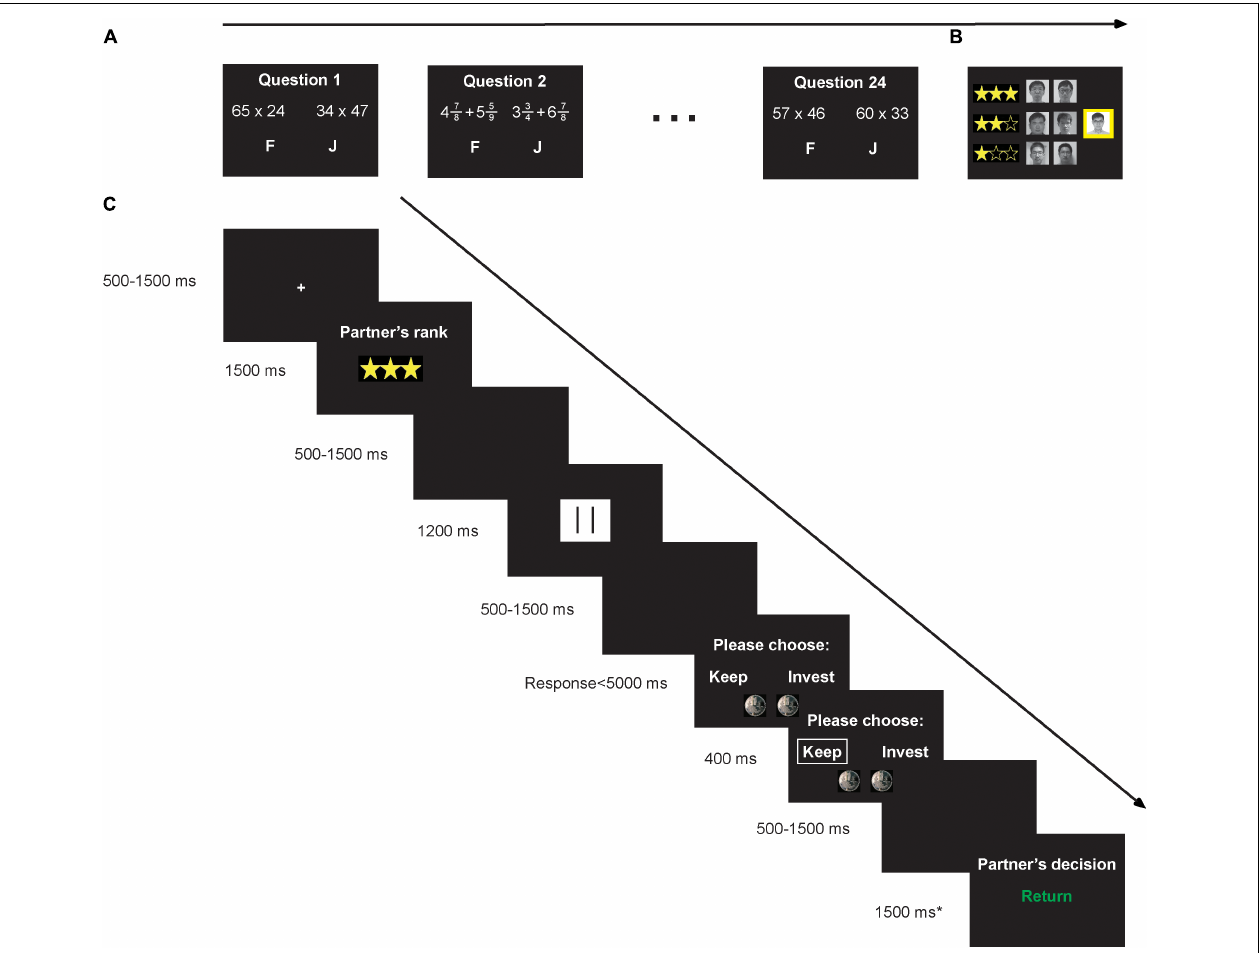
FIGURE 1 | Schematic diagram of the experiment. (A) In the rank-inducing task (i.e., math quiz), participants were given 10 s to select which of two arithmetic expressions had a greater value by pressing the “F” or “J” key with the left or right index finger. (B) Upon completion of the quiz (24 problems in total), participants were shown their performance ranking in comparison with six same-sex confederate players. All participants were assigned a middle (2-star) ranking, highlighted in yellow. (C) In TG, participants acted as Investor with Trustees of lower and higher status. On each trial, participants viewed the Trustee’s ranking from the math quiz along with his/her promise information before deciding whether or not to invest in the Trustee. Regardless of whether the participant invested in the Trustee, participants were shown the return feedback. Return feedback was set at 50% regardless of the condition. We focused on the ERP responses time-locked to the feedback screen (noted with the